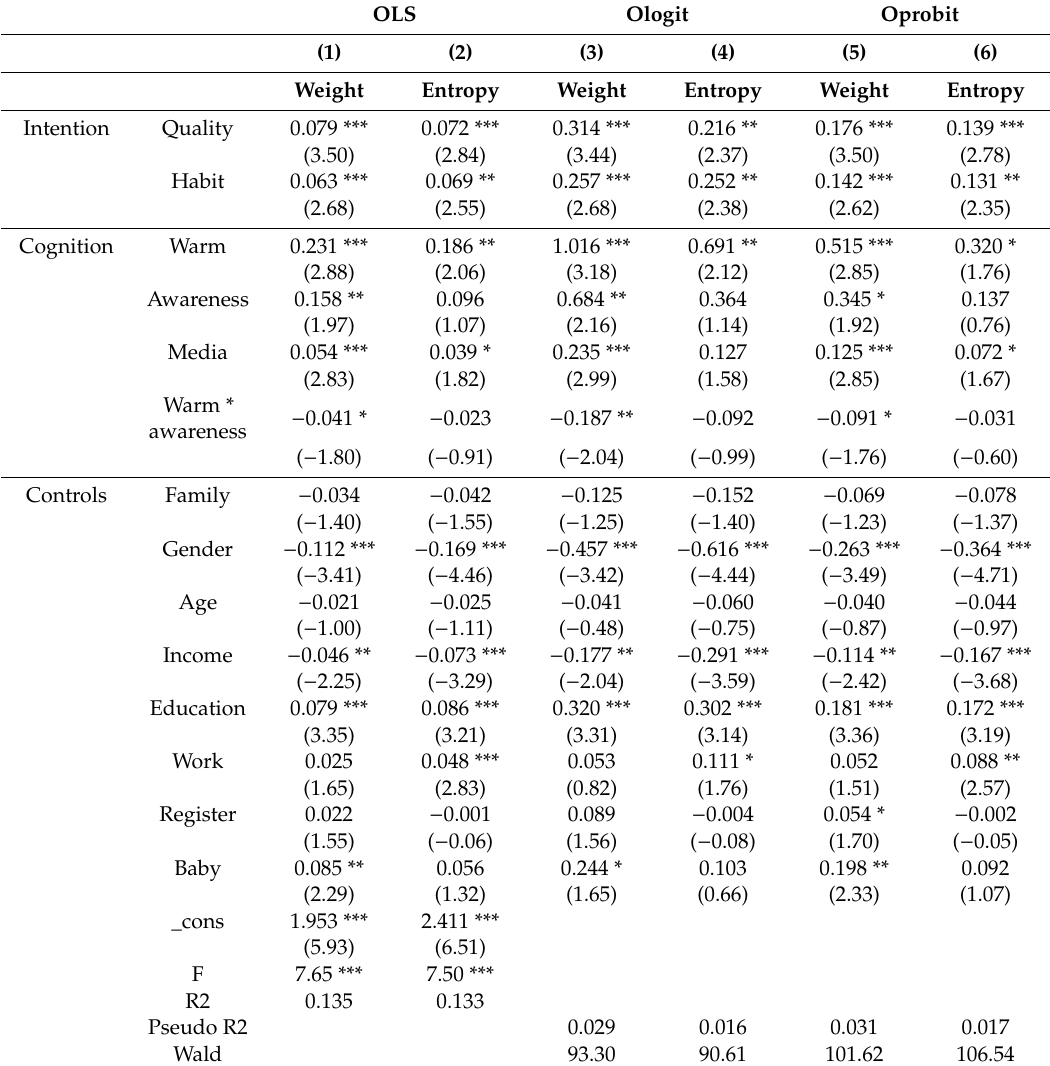
Table 7. Regression results of the interaction